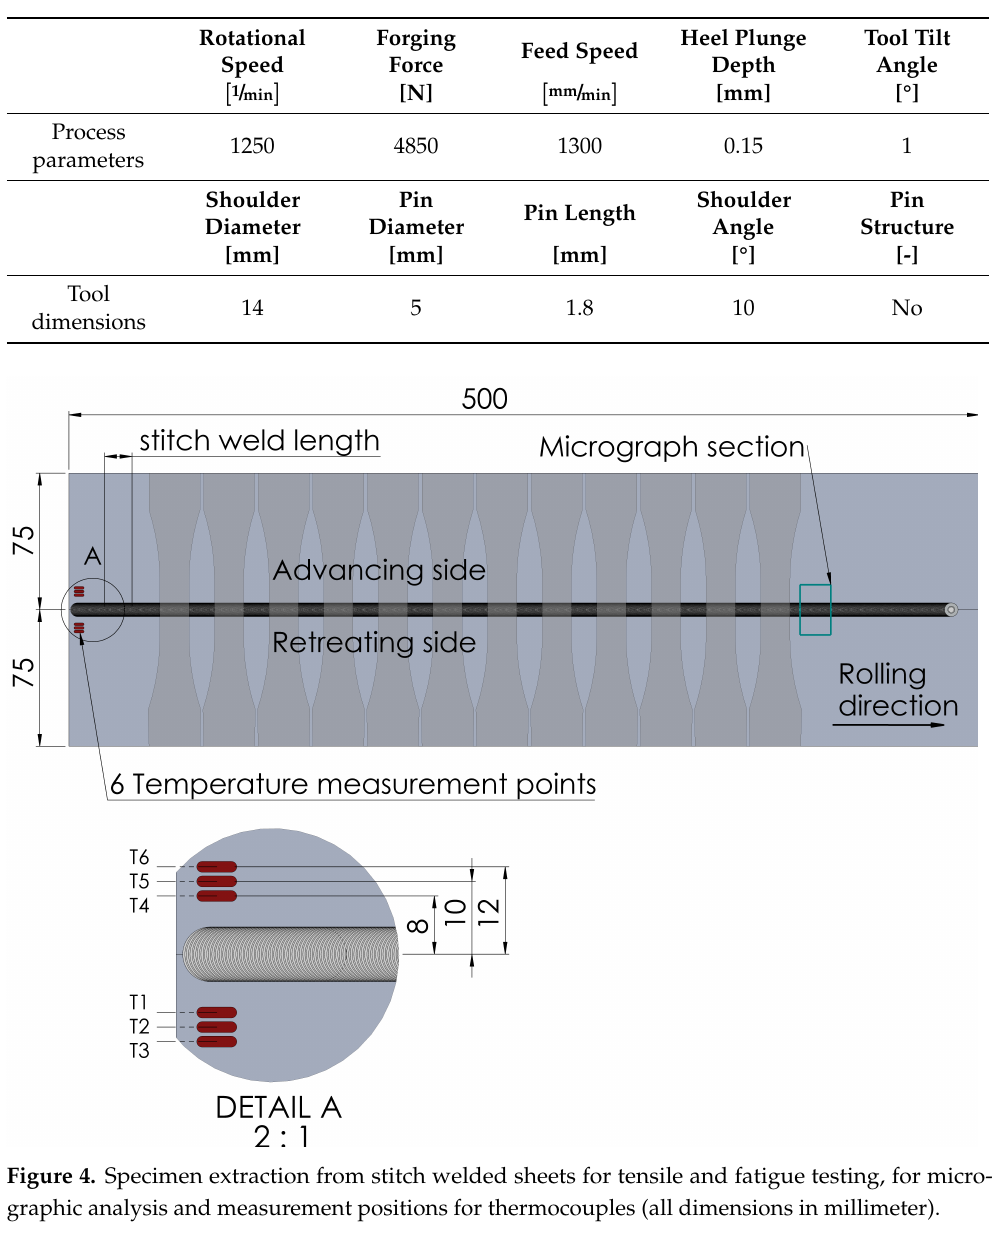
Table 2. Welding parameters and tool dimensions used for the stitch welds in this study.